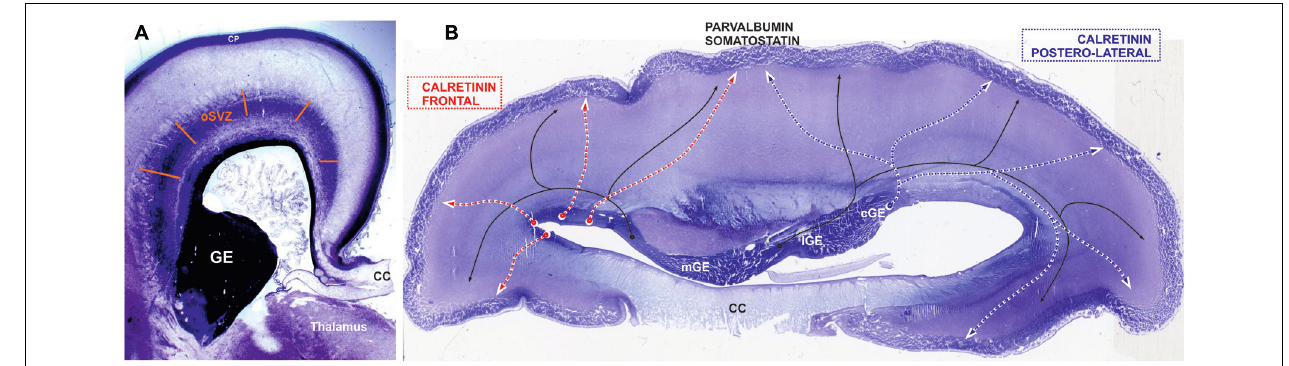
ganglionic eminence (lGE) give GABAergic neurons mainly for the subcortical structures.This spatial pattern is preserved during early trimester of gestation in primates, but with exponential increase in the pool of cGE progenitors (Hansen etal., 2013).We propose that during middle trimester of gestation, when majority of cortical neurons are produced, cGE remains the main source of cortical calretinin neurons (blue dashed line) for parietal, occipital, and temporal lobes (postero-lateral telencephalon), whereas the frontal lobe (red dashed line) is supplied with calretinin neurons from the oSVZ (see Figure 2B ). Not only the anatomical relations (rather distant postion of frontal lobe from cGE) that do not concur with exclusive production of calretinin neurons from cGE (Ma etal., 2013), but also a threefold increase in proportion of calretinin neurons in the frontal cortex cannot be achieved through increase in pool and protracted production of progenitors in